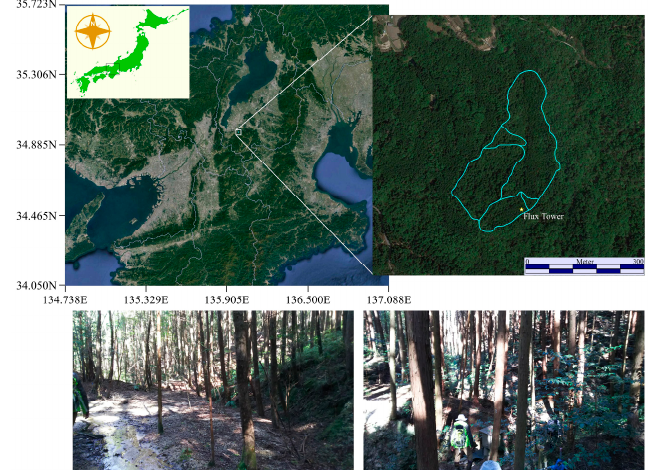
Figure 1. Location of the study area, the Kiryu Experimental Watershed (KEW) (Shiga Prefecture). The outer border indicated in the enlarged image (right) represents the watershed, whereas the inner lines indicate sub-watersheds. The bottom images represent the general landscape of the KEW. The map images are from Google Earth (Pro ver. 7.3.0.3832, Google Inc., Mountain View, CA, USA) [37].